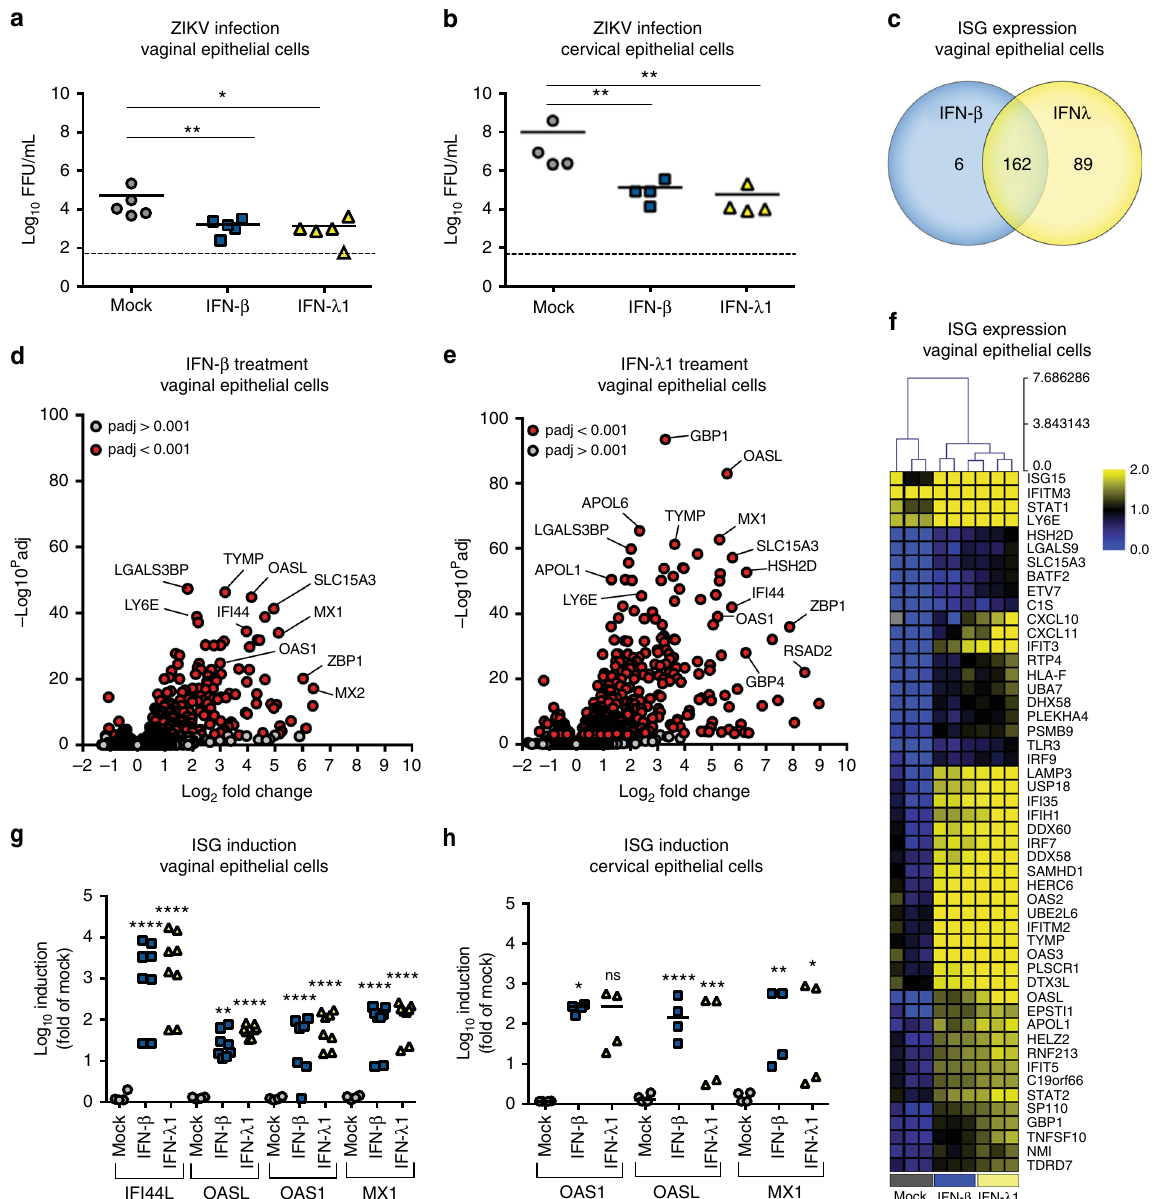
Fig. 1 IFN- λ restricts ZIKV infection of primary human vaginal and cervical epithelial cells. ZIKV infection titers from four preparations of primary human vaginal epithelial cells (HVECs, a ) and three preparations of primary human cervical epithelial cells (HCECs, b ) treated with medium (mock) or 100 ng/mL of IFN- β or IFN- λ 1 (~16 h) and then infected with ZIKV (Paraiba 2015) for 48 h. Note, one of the biological preparations of HVECs was interrogated in two separate experiments. Solid lines indicate mean values, and dotted lines denote limit of detection. c Venn diagram of transcripts differentially expressed by IFN- β or IFN- λ 1 treatment of HVEC as assessed by RNAseq. d , e Volcano plots of HVEC treated with IFN- β ( d ) or IFN- λ 1 ( e ) denoting ISGs (red circles) differentially expressed by treatment ( P < 0.001, as determined using the DeSeq2 package in R). Transcripts that were not differentially expressed are denoted by gray circles. f Hierarchical clustering heat map (based on log(RPKM) values) of the top 50 ISGs induced by treatment of HVECs with IFN- β or IFN- λ 1 compared to mock-treated controls. Color intensity indicates the level of gene expression (yellow for upregulation and blue for downregulation), and gray indicates that no reads were detected for that transcript. g , h Induction of representative ISGs ( IFI44L , OASL , OAS1 , and MX1 ) after treatment of HVECs ( g ) or HCECs ( h ) with 100 ng/mL of IFN- β or IFN- λ 1 for 16 h as assessed by RT-qPCR. Statistical analyses in a , b , g , and h were performed using a one-way ANOVA (ns = not signi fi cant; *, P < 0.05 **, P < 0.01 ***, P < 0.001 ****, P <